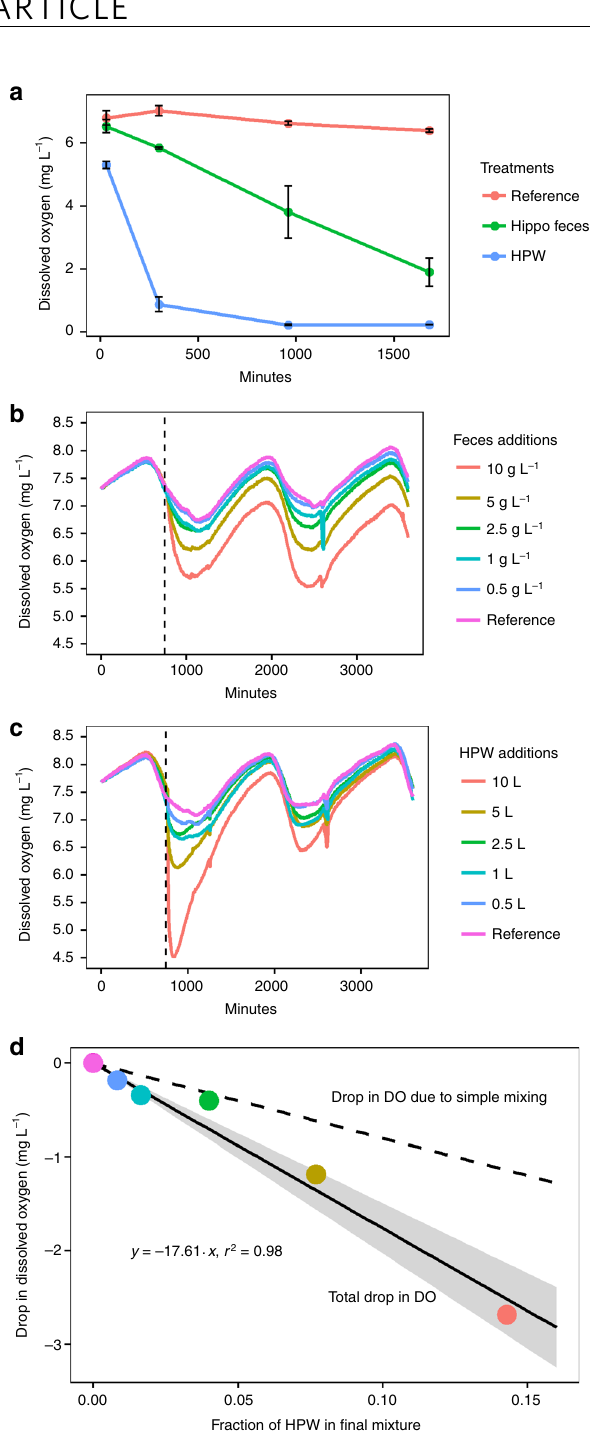
Fig. 2 Oxygen consumption by river water after addition of either hippopotamus feces or hippo pool water (HPW). a Dissolved oxygen for the three treatments in the microcosm experiment (reference, hippopotamus feces, and HPW). Errors bars re fl ect standard deviation. b Dissolved oxygen over 2.5 days for the 6 experimental stream channels with variable amounts of hippopotamus feces added (dashed line indicates time of addition). c Dissolved oxygen over 2.5 days for the experimental stream channels with variable amounts of HPW added (dashed line indicates time of addition). d The linear relationship between maximum drop in dissolved oxygen and fraction of added HPW is shown as a solid black line with points corresponding to the colors in c . 95% con fi dence intervals shown in gray. The dashed line represents the drop in dissolved oxygen expected for simple mixing of anoxic water with oxic